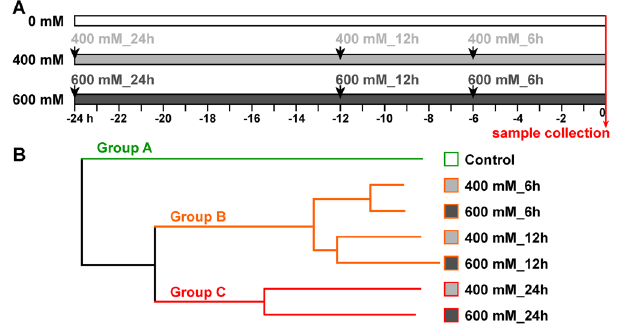
Figure 1. Samples collection and hierarchical cluster dendrogram of all the samples. ( A ) The seedlings were treated at 24 h, 12 h, and 6 h using 400 mM or 600 mM NaCl before samples collection. All the samples including control (0 h, without treatment) were collected at the same time to exclude the effects of circadian. ( B ) hierarchical cluster dendrogram of normalized transcript abundances from seven samples based on the complete distance